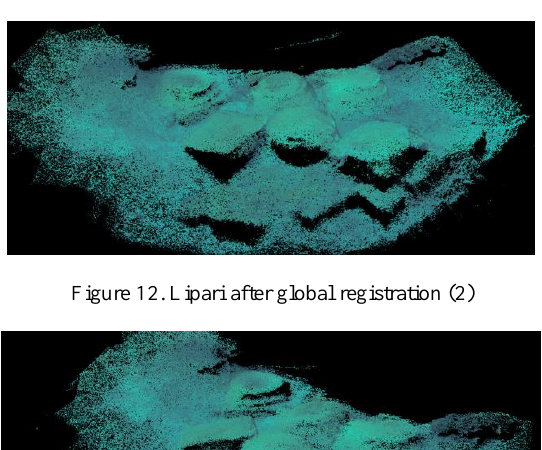
Figure 11. Lipari after global registration (1)